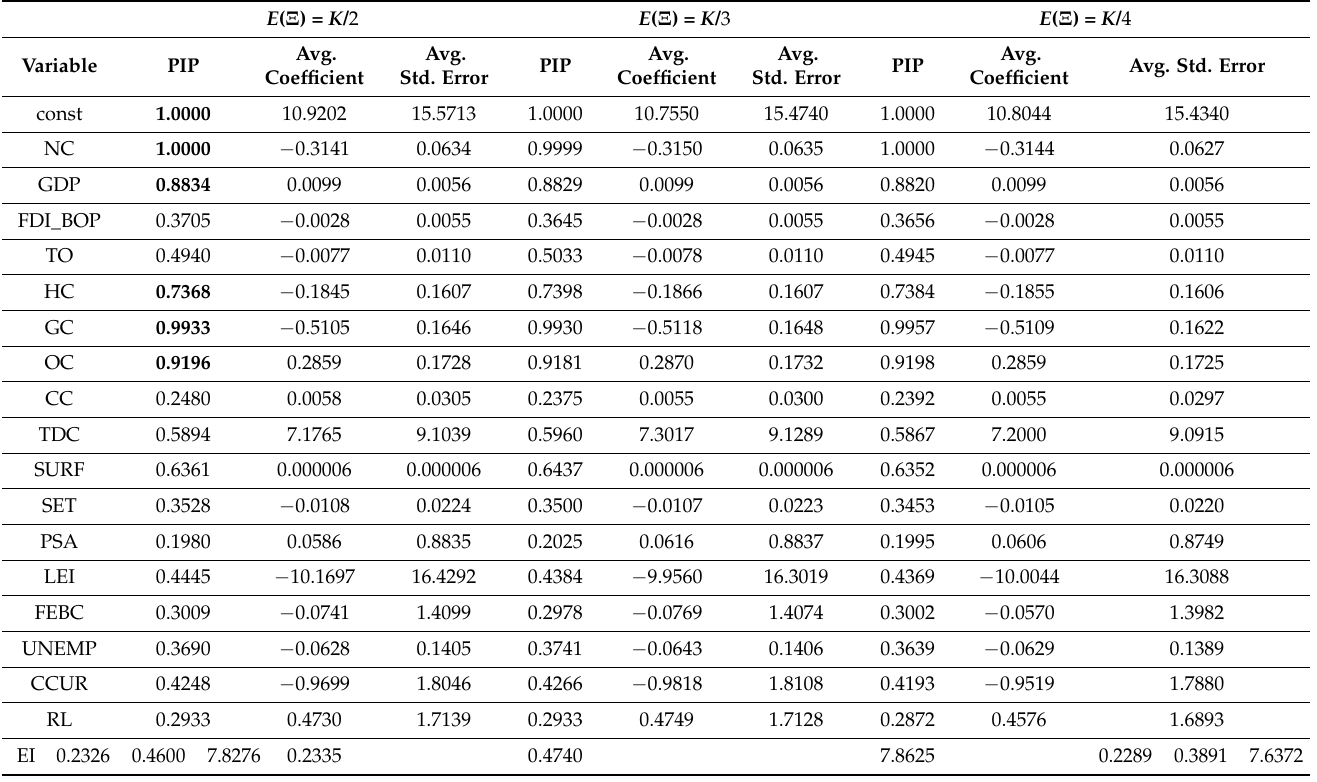
Table 4. Posterior estimates of renewable consumption determinants in 2015 for different average prior model sizes.